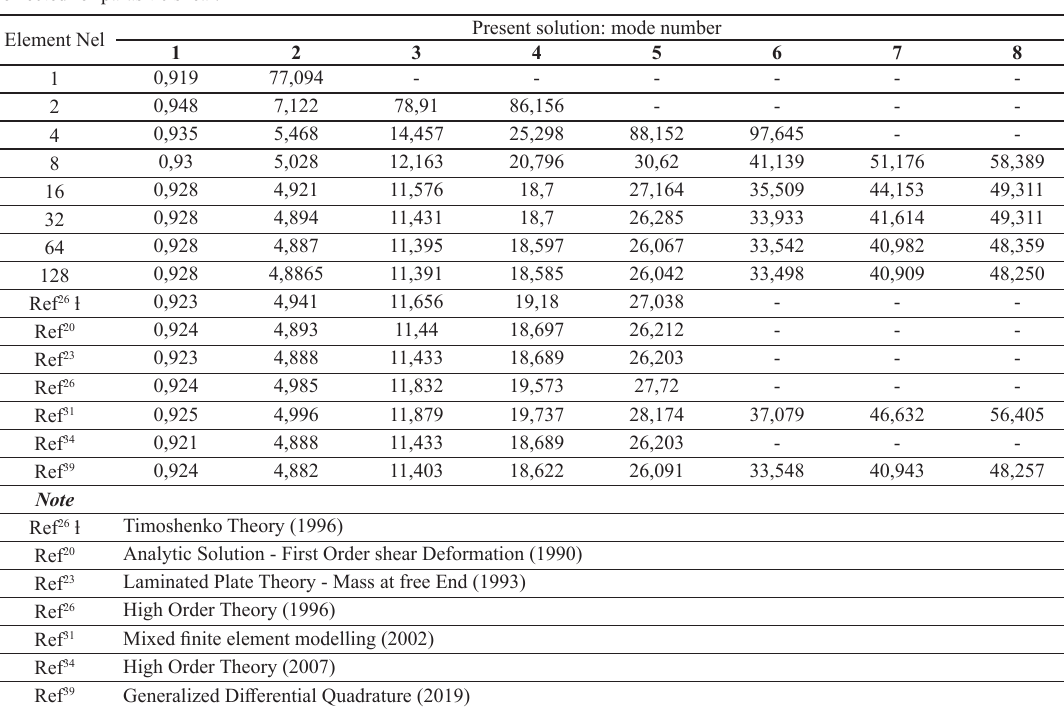
Table 3. Natural frequencies (nondimensional values) for CF beam - Laminated composite with (0/90/90/0) lamination scheme. Model corrected for parasitic shear. Element